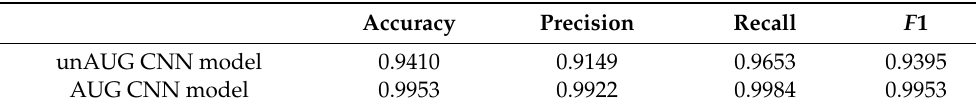
Table 1. The prediction performances of the optimized models on simulation data.